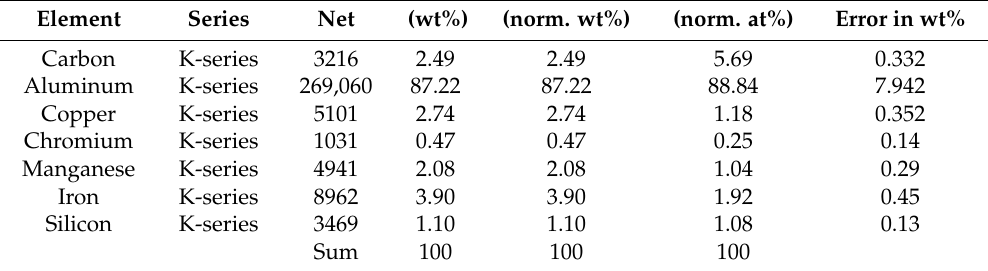
Table 3. Element in location B of the thixoformed part soaked for 10 min at 590 °C. Element